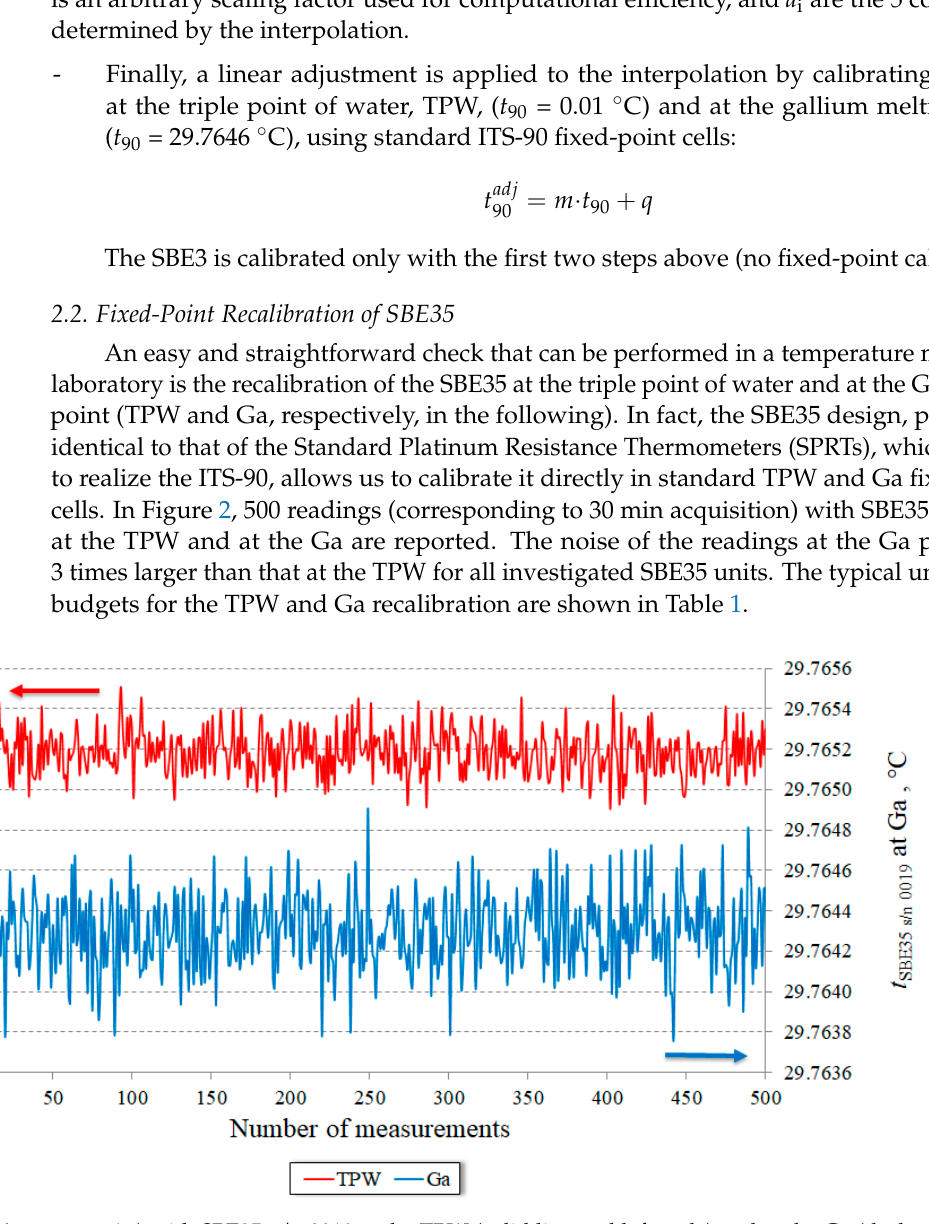
Figure 2. 500 readings (one every 4 s) with SBE35 s/n 0019 at the TPW (solid line and left scale) and at the Ga (dashed line and right scale). The peak-to-peak noise is 0.3 mK and 1.1 mK and the standard deviation is 0.054 mK and 0.185 mK, at the TPW and at the Ga, respectively.